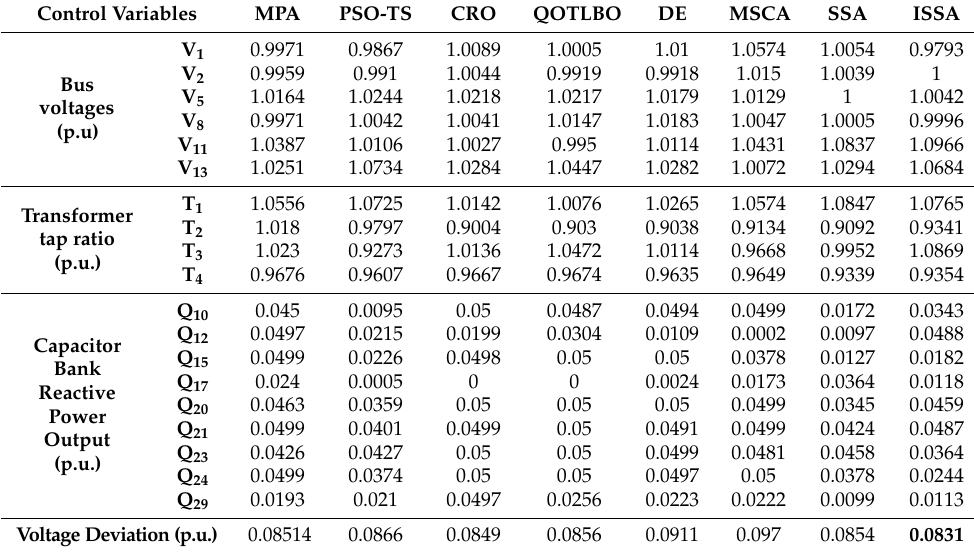
Table 11. Optimal control variables settings for VD minimization using different algorithms for IEEE 30-bus system.